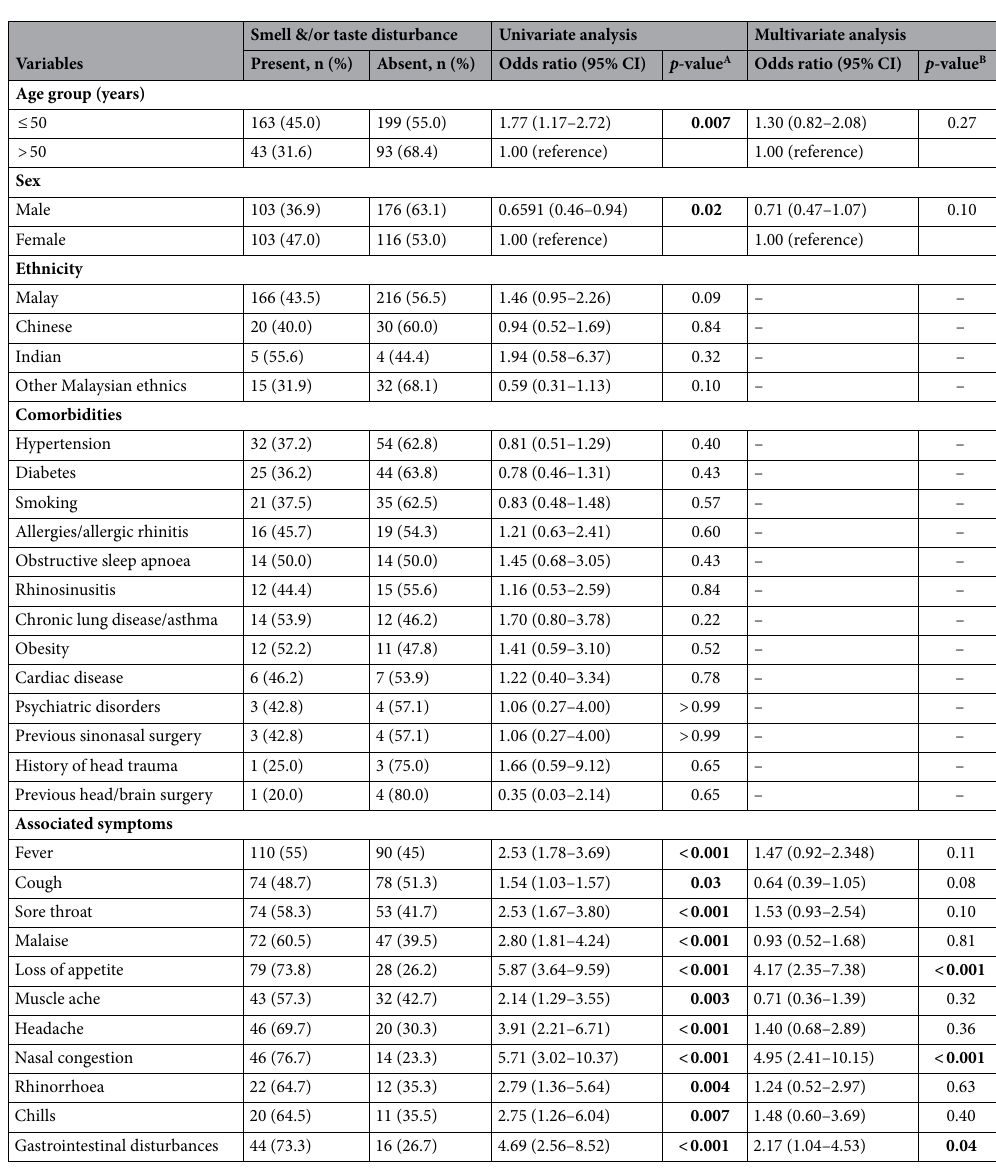
Table 3. Factors associated with smell and/or taste disturbances among COVID-19 patients in Malaysia. Bold values indicate statistical significance (p < 0.05). (–) not included in multivariate model. A p-values were calculated using Chi square test (or Fisher’s exact test when n < 5 in any cell). B p-values for multivariate analysis were calculated using multiple logistic regression (Forward